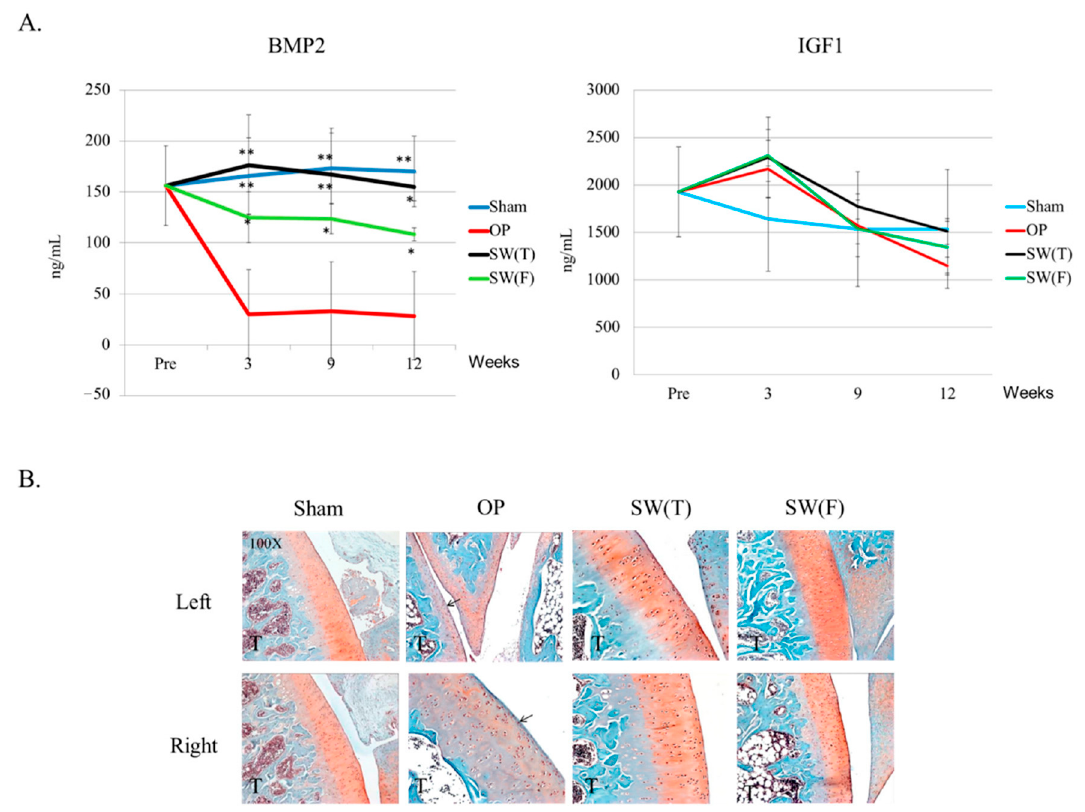
Figure 3. Enzyme-linked immunosorbent assay (ELISA) and protection of the articular cartilage of the knee: ( A ) the serum bone morphogenetic protein 2 (BMP2) and Insulin-like growth factor 1 (IGF1) levels were surveyed by ELISA. Values are the mean ± SD. * p < 0.05 and ** p < 0.01 versus the OP group. N = 6. ( B ) The images of the left and right articular cartilages of the knees showed changes in the articular cartilage in the di ff erent groups following safranin-O staining ( × 100 magnification). The arrow heads indicate fibrous tissues. N = 6. The tibia is denoted